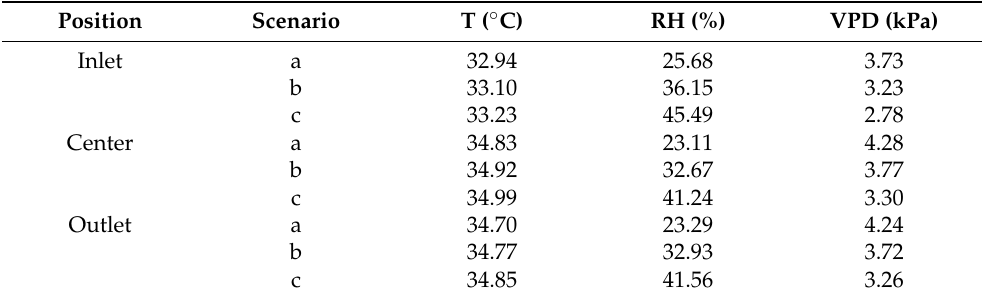
Table 6. Average of ten data of the variables: T, RH, and VPD simulated at a height from 1.9 to 2 m at the inlet, center, and outlet area of the central span of the